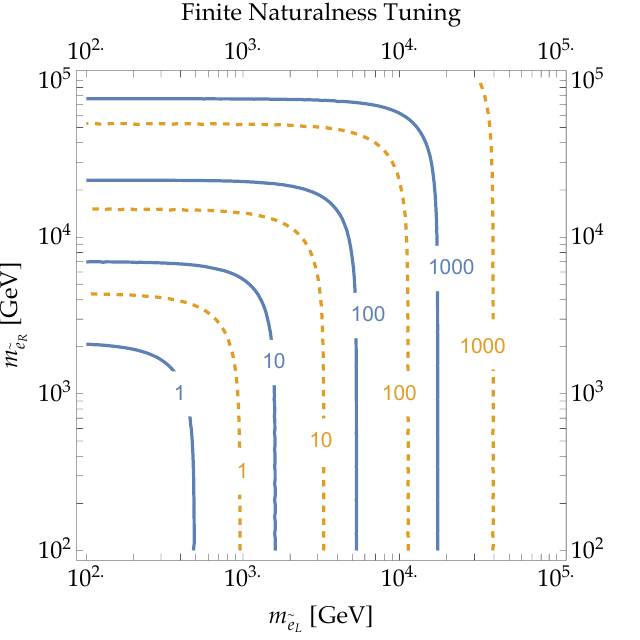
Figure 12 . \Finite naturalness" tuning measure for a model consisting of a bino and left- and right-handed selectrons. Contours correspond to (cid:1) = UV cuto(cid:11), (cid:3) = 2 10 16 GeV (blue) and 10 10 GeV (orange), with log divergences included but no (cid:2) power